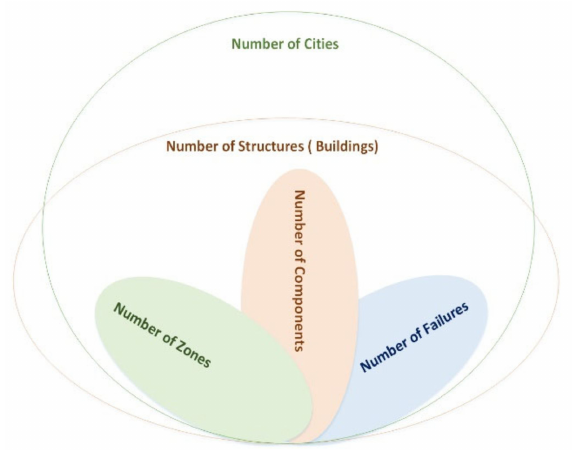
Figure 2. The multi-dimensional aspect of the FI implementation.